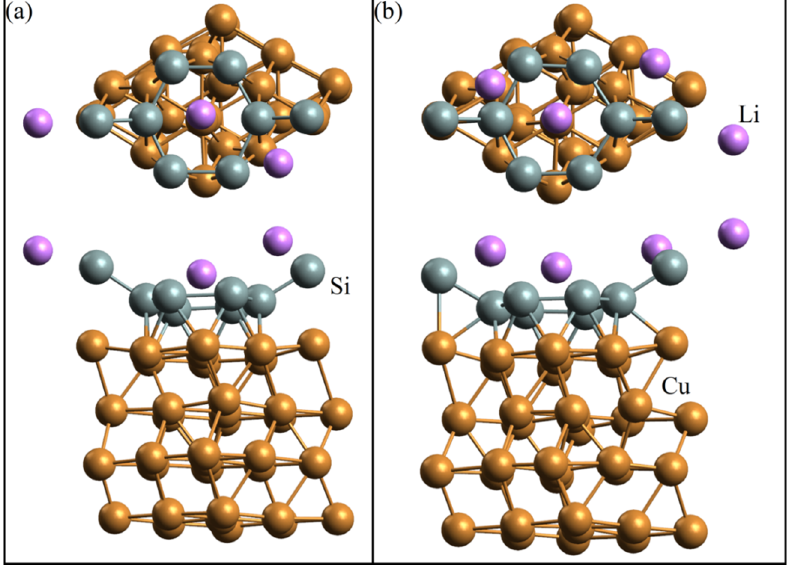
Figure 6. Geometric structures of silicene on the four-layer copper substrate with the addition of ( a ) three and ( b ) four Li atoms (after 2000 ps at a temperature of 293 K).